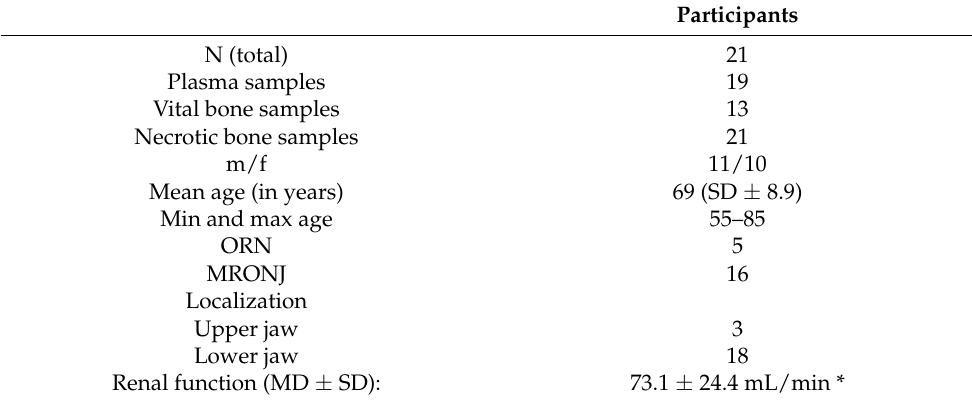
Table 1. Patient Table 1. Patient characteristics.